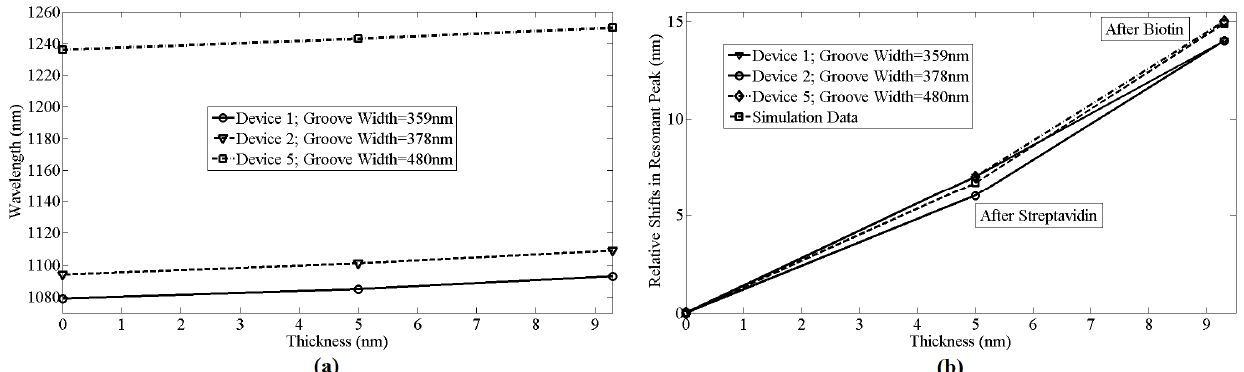
Figure 9. (a) Shifts in resonant peak due to immobilization on different gratings sensors with respect to thickness of bio-material; (b) Comparison of simulation data with measurement